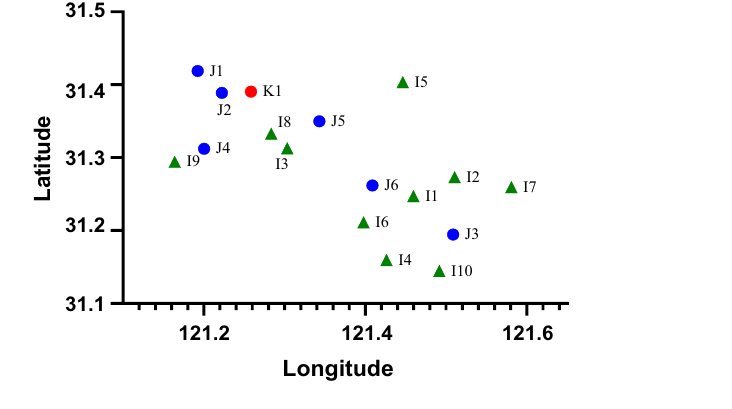
Figure 2. Layout of the proposed problem